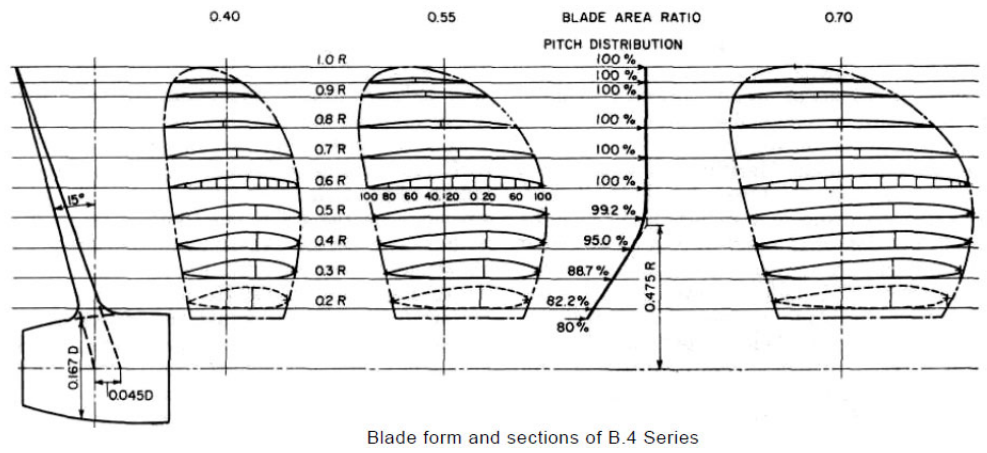
Figure 2. General plan of Wageningen B ‐ series [14].